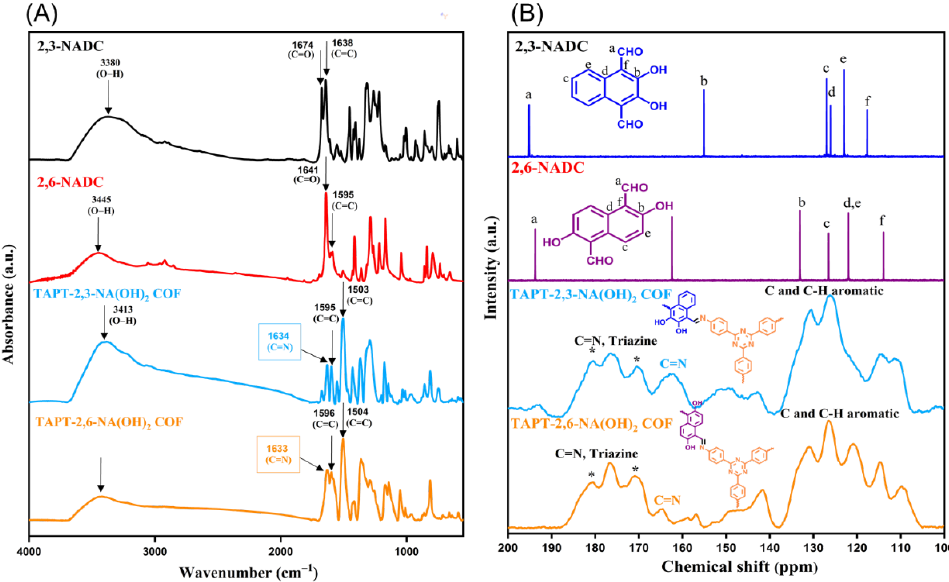
Figure 2. ( A ) FTIR spectra of 2,3-NADC, 2,6-NADC, TAPT-2,3-NA(OH) 2 , and TAPT-2,6-NA(OH) 2 COFs. ( B ) 13 C-NMR spectra of 2,3-NADC, 2,6-NADC and solid state 13 C CP/MAS NMR spectra of TAPT-2,3-NA(OH) 2 and TAPT-2,6-NA(OH) 2 COFs. * Background peaks from the instrument.